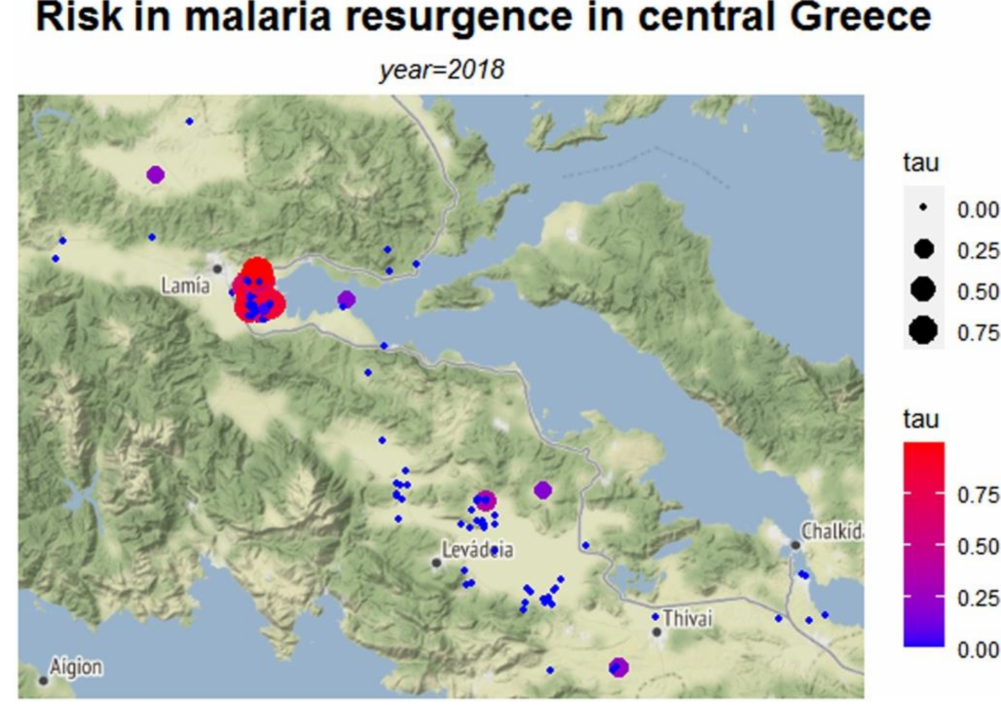
Figure 3. Map of risk of malaria transmission, computed by the EWS model ( τ estimates).